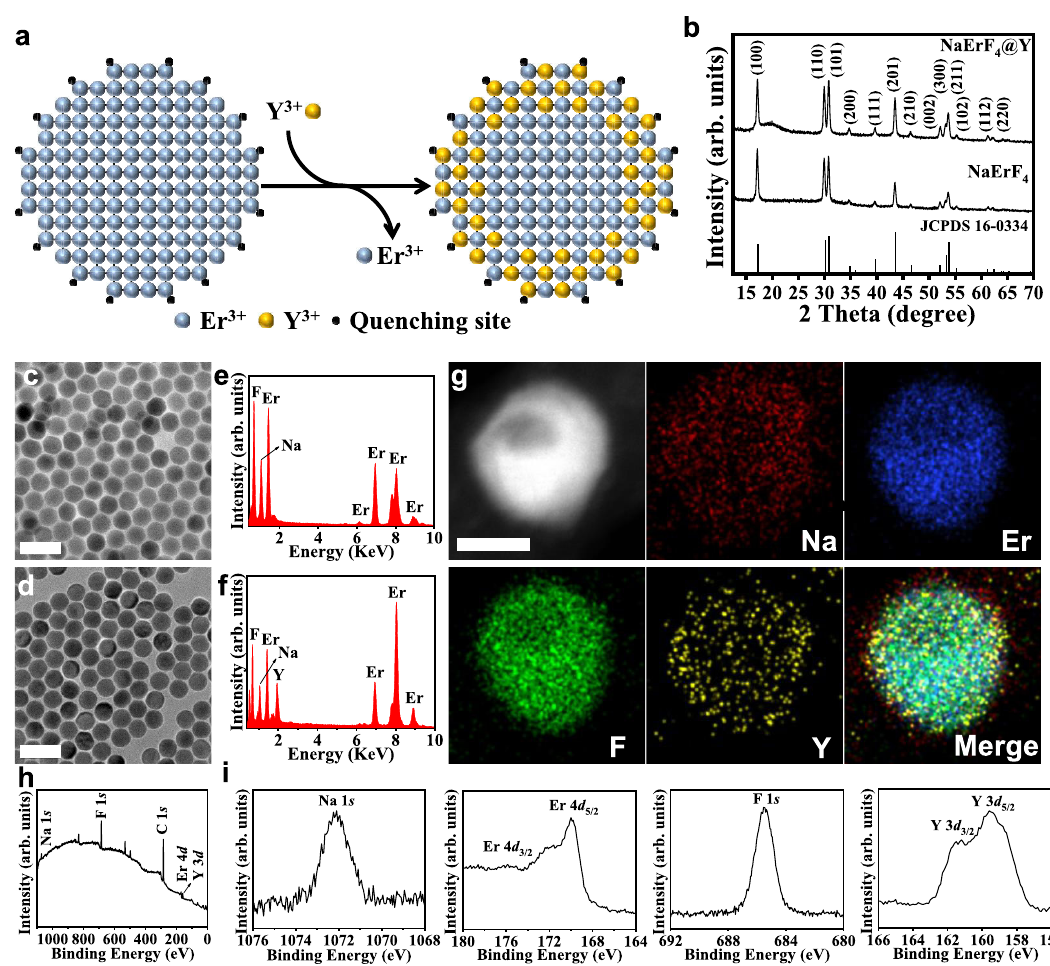
Fig. 3 Structural characterization of NaErF 4 nanoparticles before and after ion exchange. a Schematic of the NaErF4 core after ion exchange. The Y 3 + ions (yellow) would replace some Er 3 + ions (blue) on the surface and block the energy transfer to the quenching site. b X-ray diffraction (XRD) pattern of the NaErF 4 nanoparticles, obtained before and after exchange with Y 3 + ions (abbreviated as NaErF 4 @Y). c , d TEM image of the NaErF 4 nanoparticles and NaErF 4 @Y nanoparticles, respectively. Scale bar: 50 nm. e , f The EDS line-scan pro fi le of NaErF 4 and NaErF4@Y nanoparticles, respectively. g HAADF- STEM (high angle annular dark fi eld scanning TEM) of single NaErF 4 @Y nanoparticle and its corresponding elemental mapping images, Scale bar: 10 nm. h , i Full survey XPS spectrum and detailed spectra (Na 1 s , Er 4 d , F 1 s , and Y 3 d ) of NaErF 4 @Y